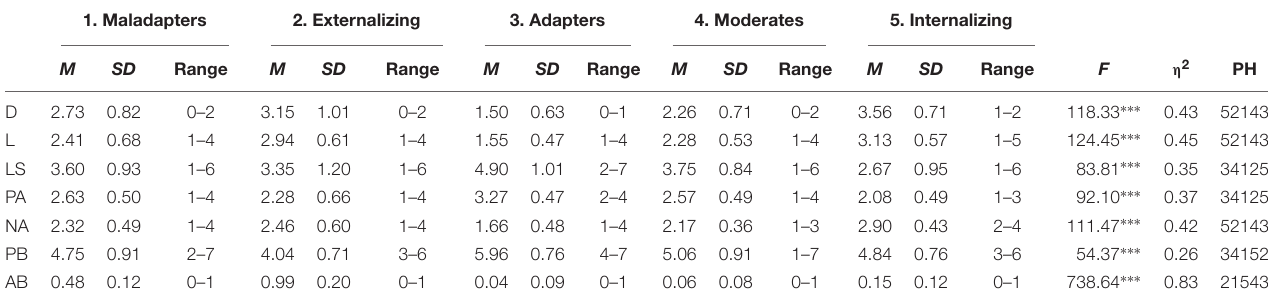
FIGURE 1 | Five psychosocial adjustment profiles based on z -values of each scale. N = 627. LS = life satisfaction; PA = positive affect; PB = prosocial behavior; AB = antisocial behavior; L = loneliness; NA = negative affect; D = depression. The profiles from left to right are maladapters, externalizing problem individuals, adapters, moderates, and internalizing problem individuals, respectively. TABLE 3 | Mean differences in study variables among psychosocial adjustment profiles.